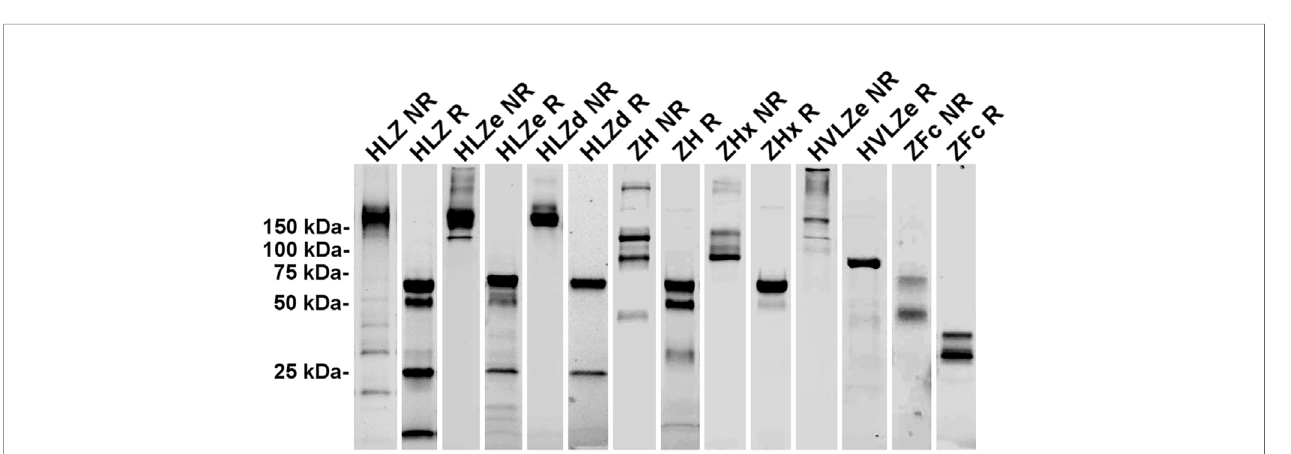
FIGURE 3 | Puri fi cation of IgG fusions. Agroin fi ltrated leaf material between 1 and 3 plants per construct was homogenized, clari fi ed, and puri fi ed by protein G af fi nity chromatography. The peak elutions were pooled and separated on nonreducing (NR) and reducing (R) SDS-PAGE using stain-free polyacrylamide gels. Representative lanes for each construct are compiled from multiple gels